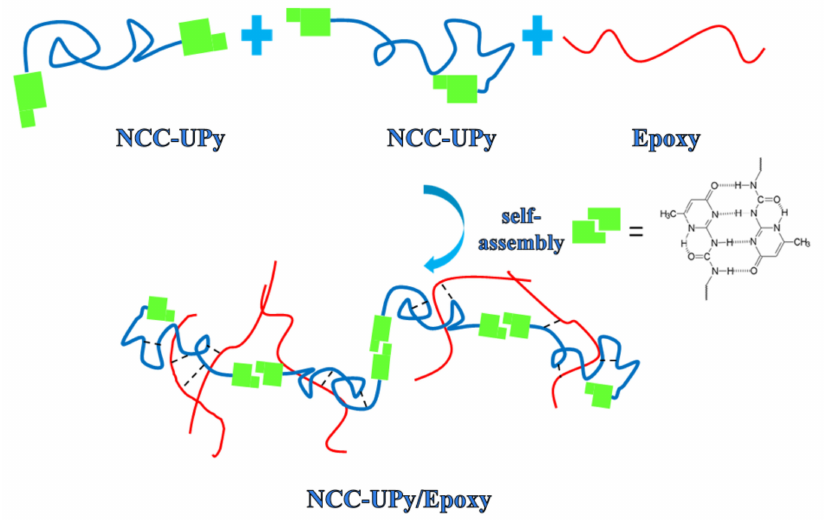
Figure 2. Schematic illustration of the formation of an epoxy nanocomposite membrane based on NCC-UPy and